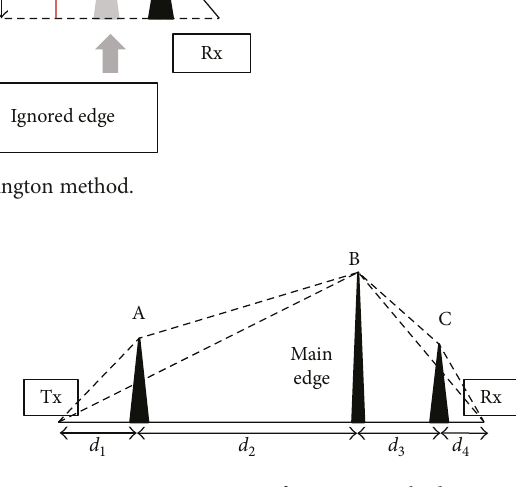
Figure 2: Concept of Deygout